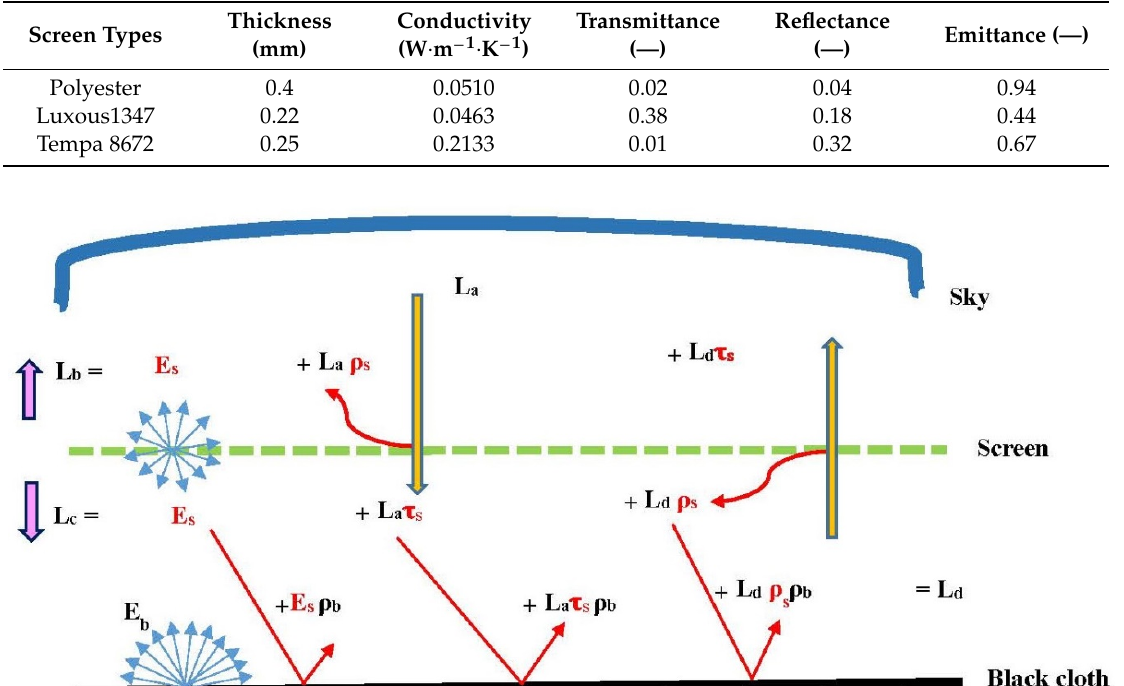
Table 3. Long-wave radiation properties of the thermal screens.